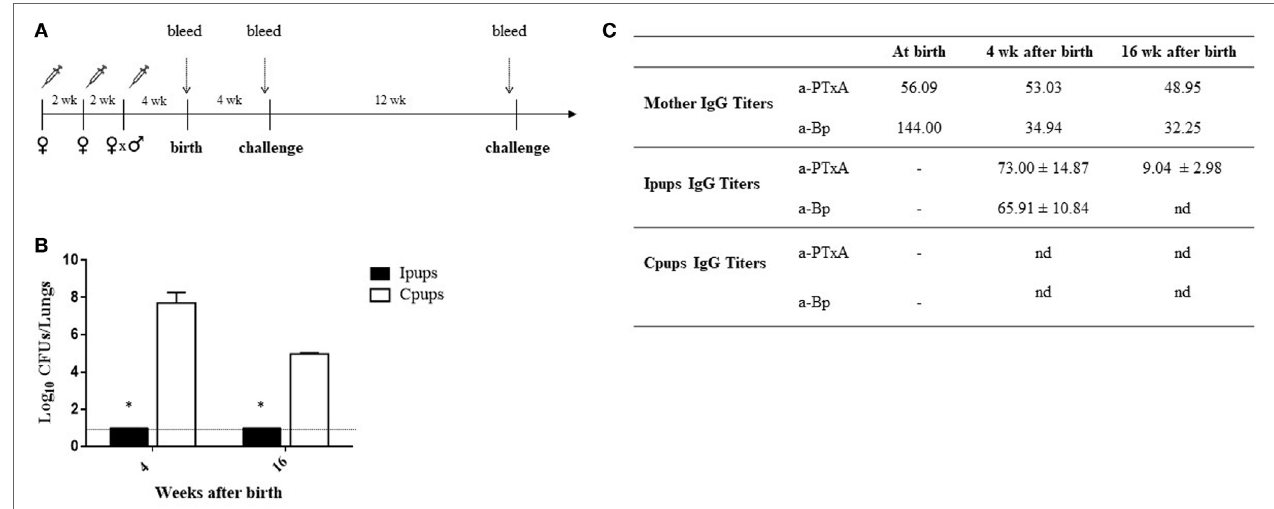
FigUre 1 | Effect of maternal immunization on protection of offspring against Bordetella pertussis infection. (a) Schematic representation of the maternal vaccination and challenge protocols. Female mice were vaccinated twice with a commercial acellular pertussis (aP) at a 2-week interval; mated with male mice; and when the vaginal plug was detected, a third aP dose was administered. Non-immunized females were mated with male mice at the same time as the immunized females. Mice were born 3–4 weeks after the last immunization. Mice born to aP-immunized or non-immunized females (controls) were challenged with B. pertussis at 4 and 16 weeks after birth. Mothers and pups were bled at different time points as indicated by the dotted vertical arrows. (B) Short- and long-term protection of offspring through maternal immunization. Mice born to aP-immunized (Ipups n = 6, black bars) or non-mmunized (Cpups n = 6, white bars) females were challenged with B. pertussis Tohama I at 4 and 16 weeks after birth. The number of bacteria recovered from mouse lungs, expressed as the log 10 of CFUs per lungs, is plotted on the ordinate for the times after birth in weeks indicated on the abscissa , with the data representing the means ± the SD. The dotted horizontal line indicates the lower limit of detection. * p < 0.001 Ipups versus Cpups. (c) The anti-whole-cell- B. pertussis (a-Bp)- and anti-pertussis toxin (a-PTxA)-specific IgG titers were determined in the mother and in the offspring at the indicated time points. The titers are expressed as the geometric mean of the data from each group. p < 0.001 a-PTxA and a-Bp IgG titers in Ipups at 4 weeks after birth versus those detected at 16 weeks after birth. The results from one representative experiment are shown. nd, not